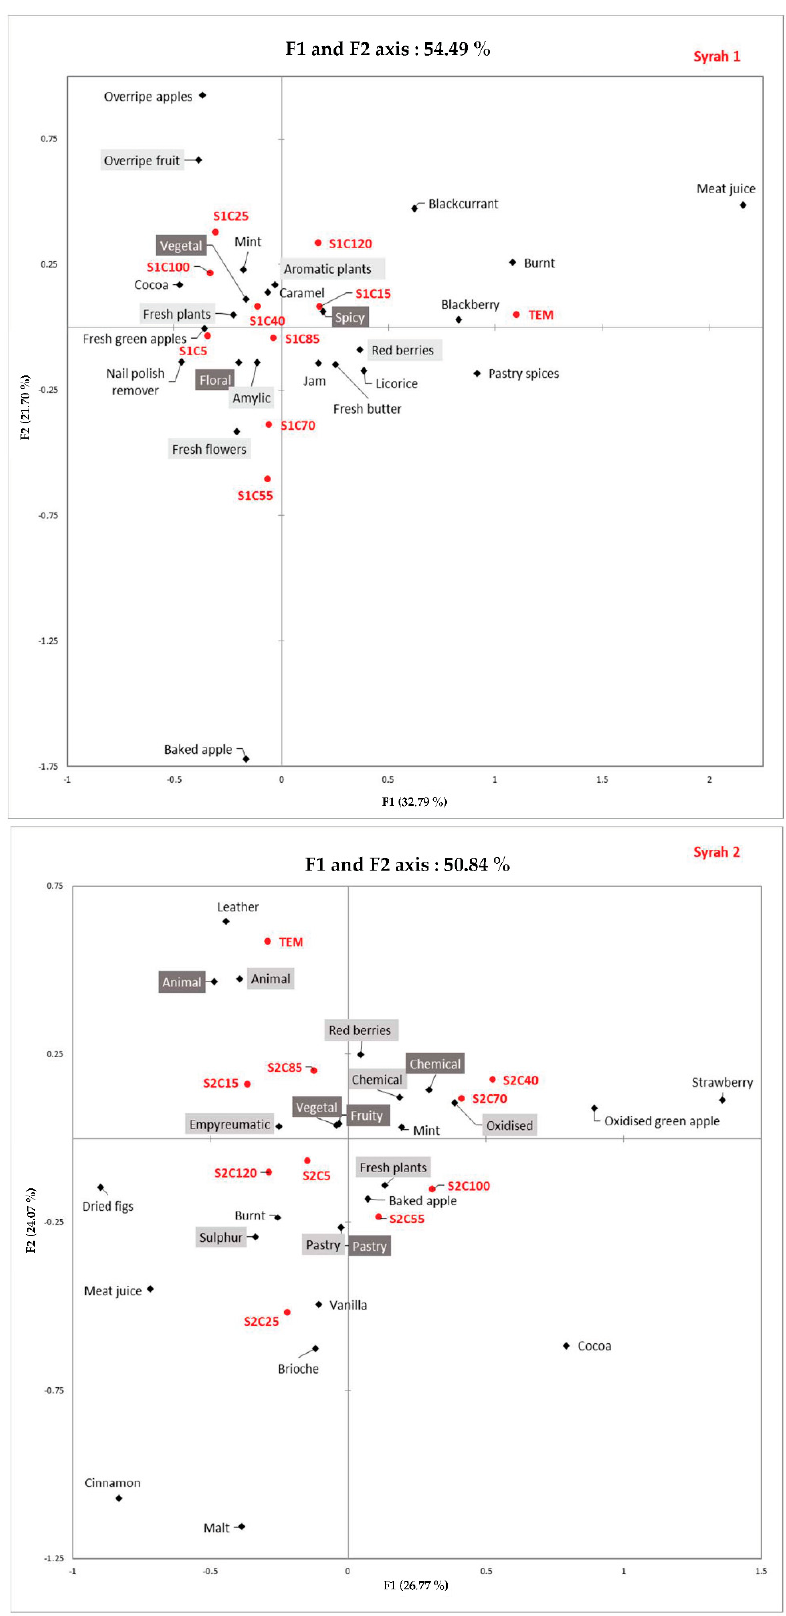
Figure 2. Correspondence analysis of HCATA results for each sample. SXCY with X = the number of samples and Y = the corresponding spiked concentration. Families–Sub-families–olfactory terms. TEM = control wine without acetaldehyde addition.